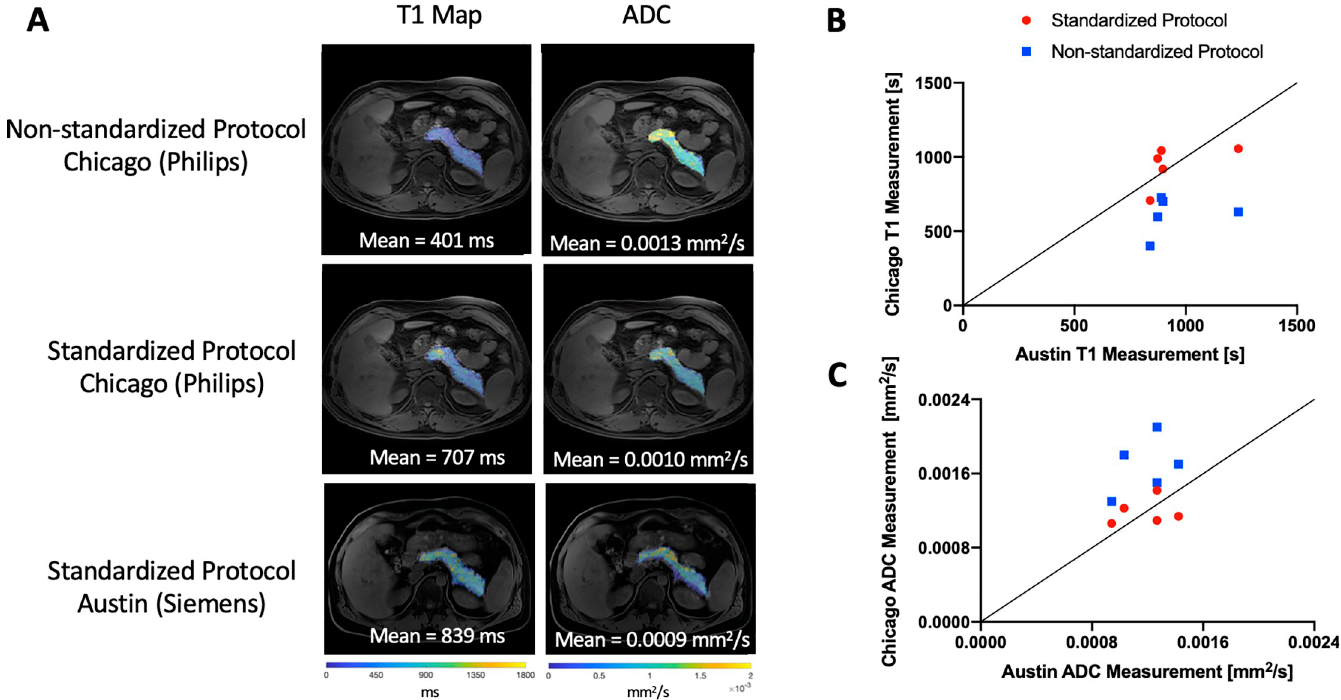
Fig 4. Representative difference in quantitative MRI measurements induced by use of different image processing between sites. A) Representative maps of T1 relaxation time (left column) and ADC (right column) displayed in pseudo color over a T1-weighted image. The top row displays images acquired in Chicago and processed using a non-standardized image processing protocol, demonstrating differences in T1 and ADC values from the standardized protocol (middle row). Images acquired and processed using the standardized MAP-T1D protocol in Chicago on a Philips MRI scanner (middle row) and Austin on a Siemens MRI scanner (bottom row) display concordance for T1 and ADC. All sets of parametric maps are scaled identically for visualization. B) Mean pancreatic T1 values are more reproducible between two sites (Chicago and Austin) using the standardized image analysis protocol (red circles), than when using non-standardized image processing (blue squares). The line of identity indicates perfect agreement. C) Mean pancreatic ADC values are more reproducible between two sites (Chicago and Austin) when using the standardized image analysis protocol (red circles), than when using non-standardized image processing (blue